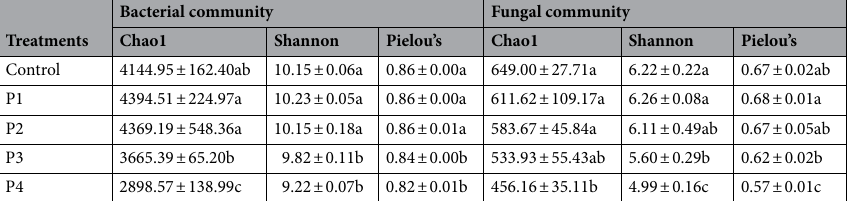
Bacterial community Treatments